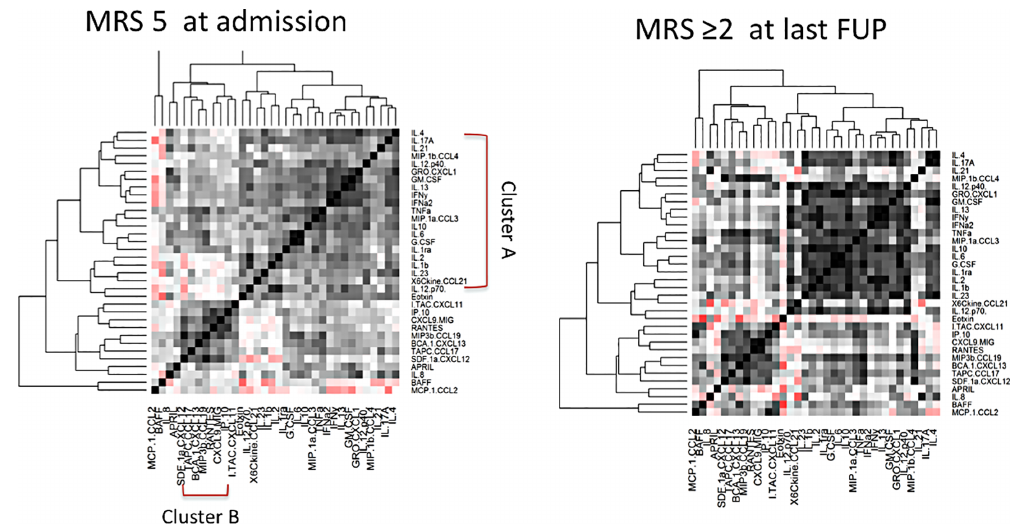
Fig 5. Heat map representation of cytokine/chemokine molecule interaction in the CSF of patients with all encephalitis with severe encephalopathy at admission (modified Rankin scale, MRS 5) and worse disability at follow up (MRS > 2). The cluster B molecules showed similar positive correlations between those with higher severity of encephalopathy and those with disability in follow